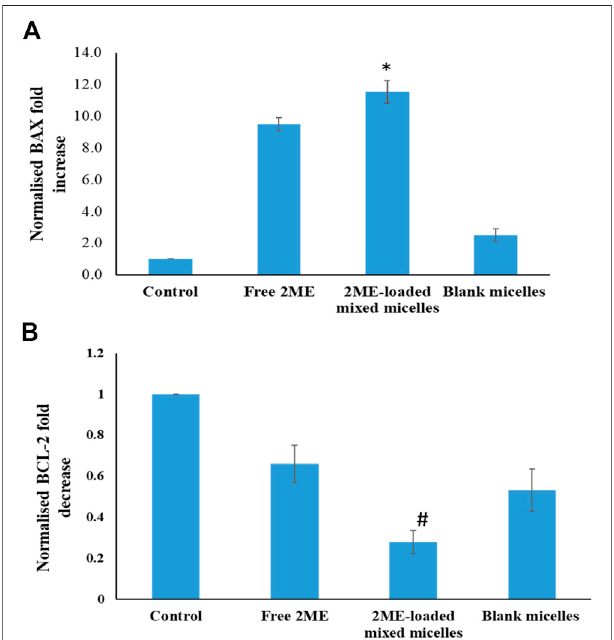
FIGURE7| A.BAXandB.BCL-2expressionlevelsoftheblankmicelles, free-2ME, and 2 ME-loaded micelles exposed PC-3 cells and vehicle control cells after 24 h. BAX and BCL-2 expression levels were normalized with regardto control cells. * represents signi fi cantdifference between2 ME- loaded micelles vs other formulations group ( p < 0.05). Values are expressed as mean ± SD ( n (cid:2) 3).